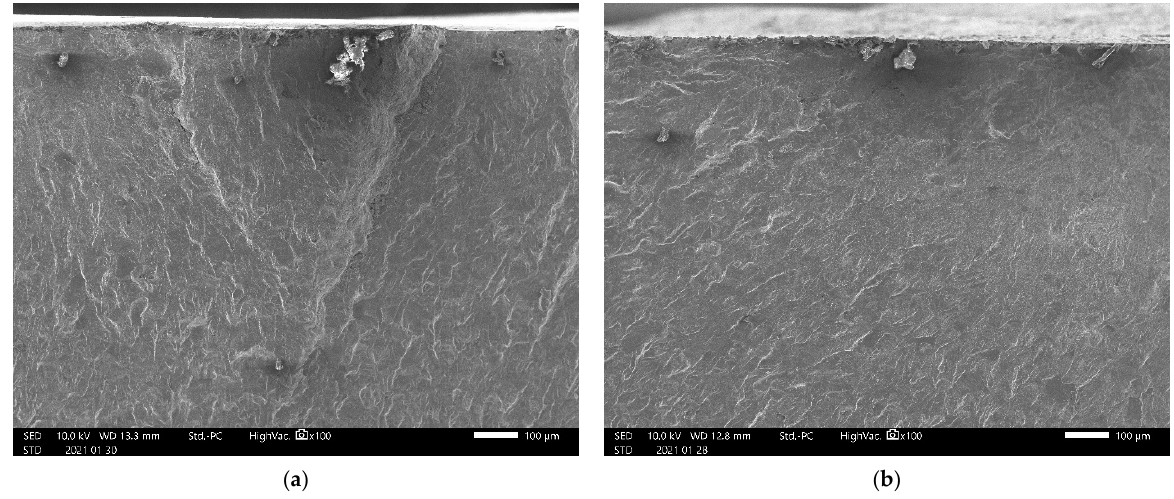
Figure 13. Aspect of the fractured surface observed by SEM. ( a ) Non-peened specimen ( σ a = 229 MPa, N = 688,800); ( b ) specimen treated by laser cavitation peening ( σ a = 319 MPa, N = 516,300).